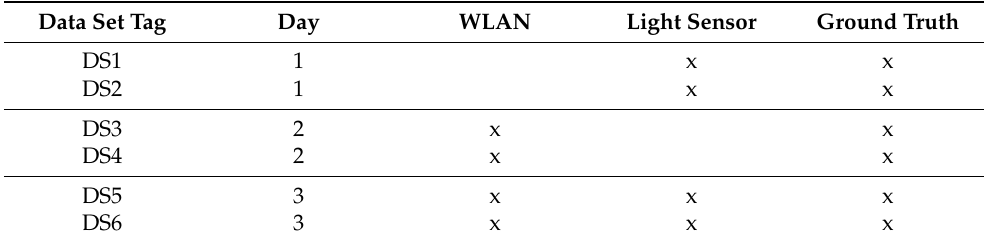
Table 1. Overview of data sets used in this work. Data Set